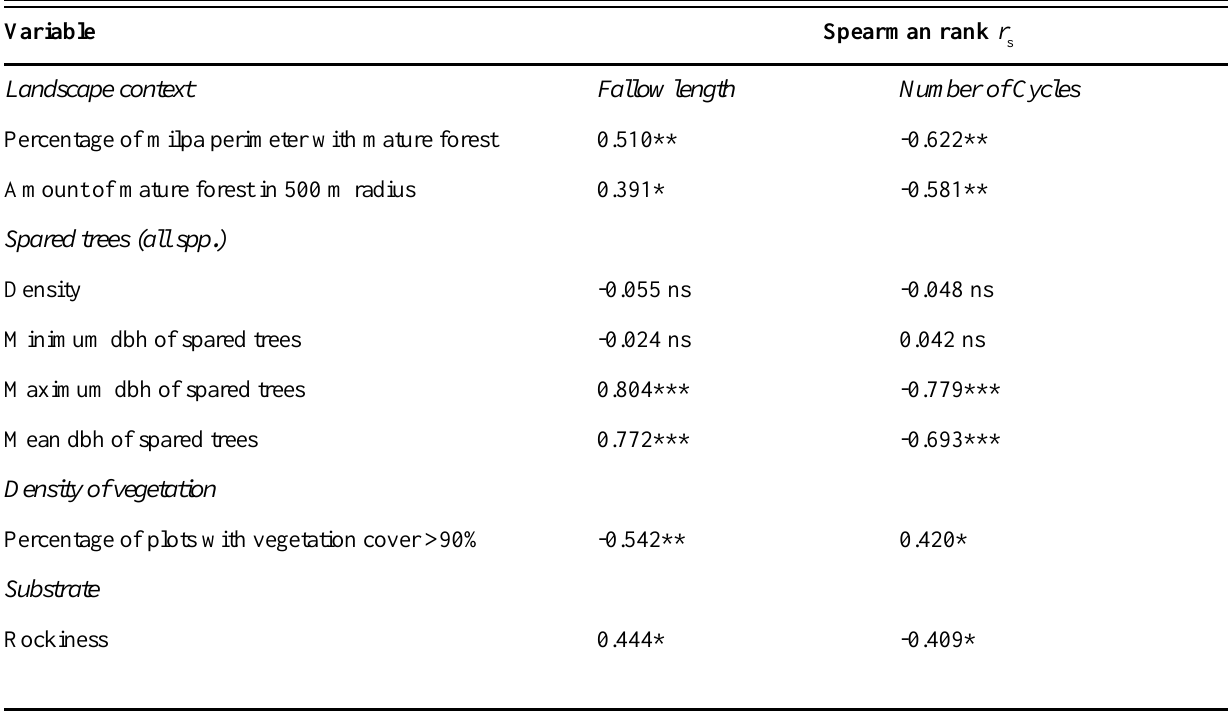
Table 4. Spearman rank correlations of length of the last fallow period and the number of cycles with other site characteristics ( n =